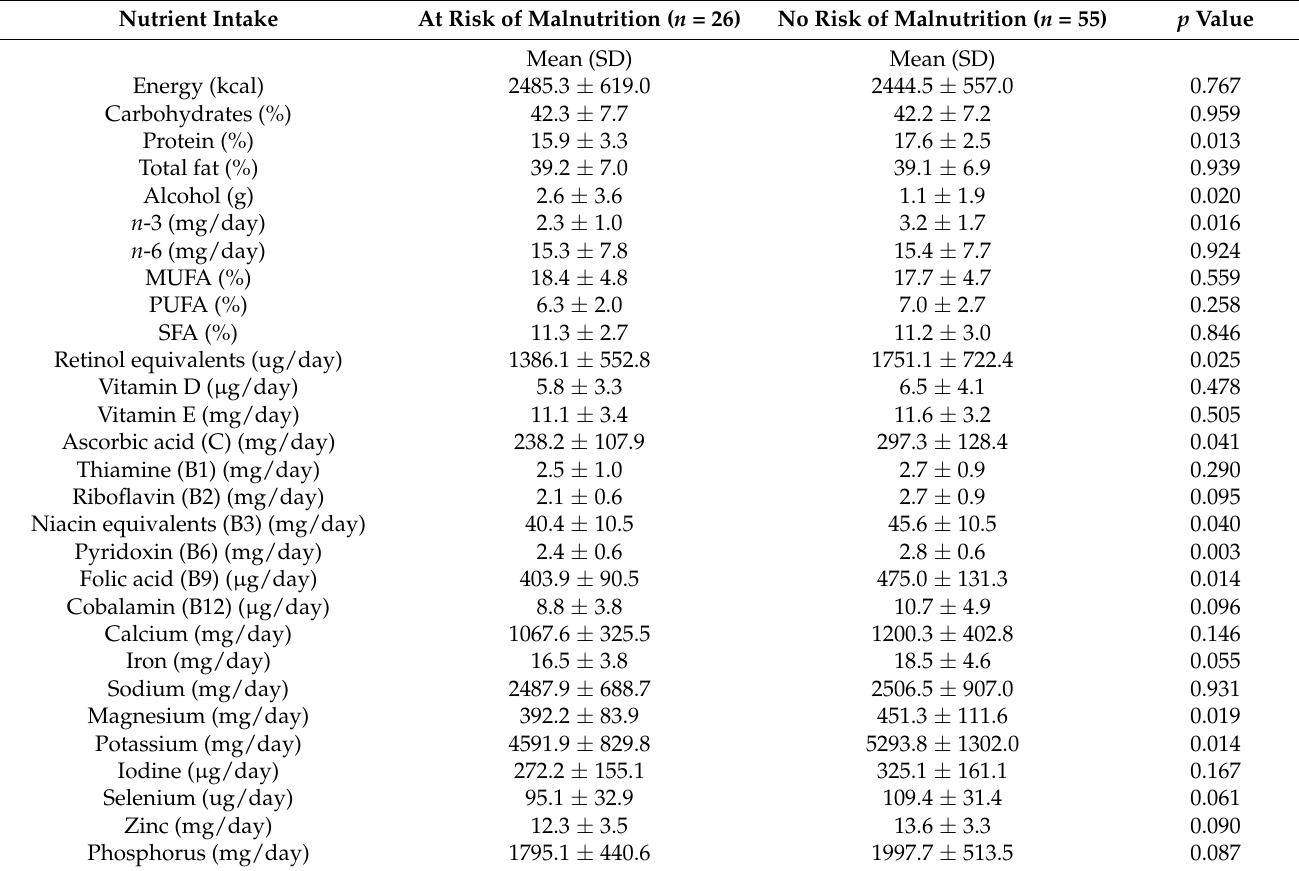
Table 5. Differences in nutrients intake between malnutrition groups in non-frail